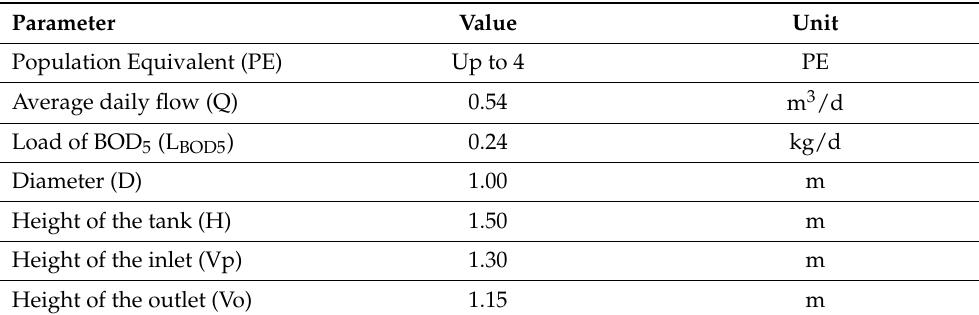
Table 3. Assumed and required effluent quality parameters.